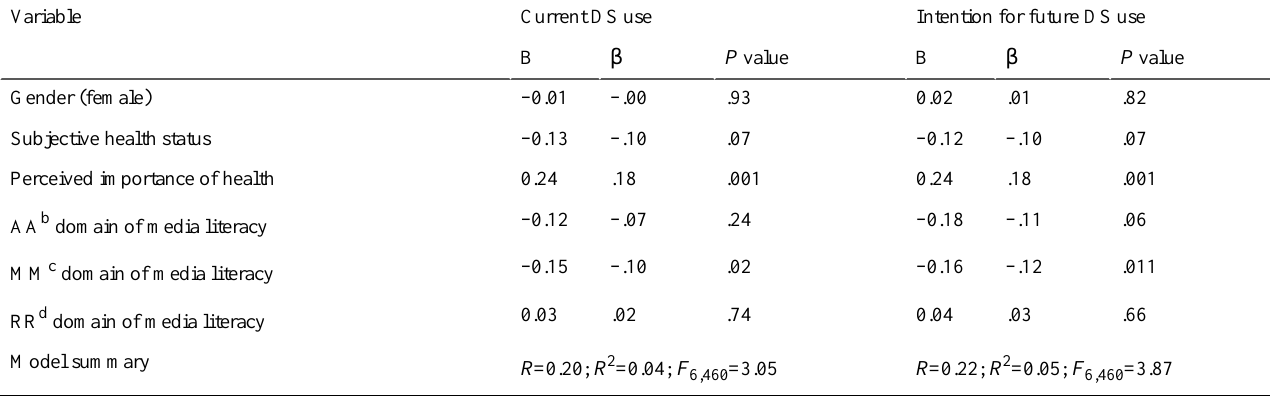
Table 5. Multiple regression analysis of the frequency of DS a